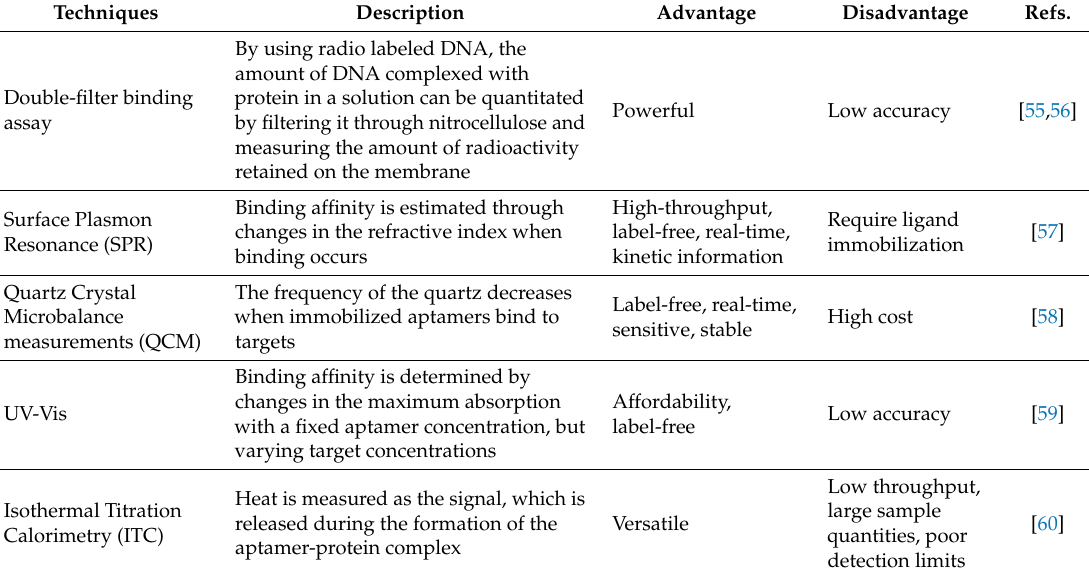
Table 2. Summary of bioanalytical techniques for kinetic characterization of